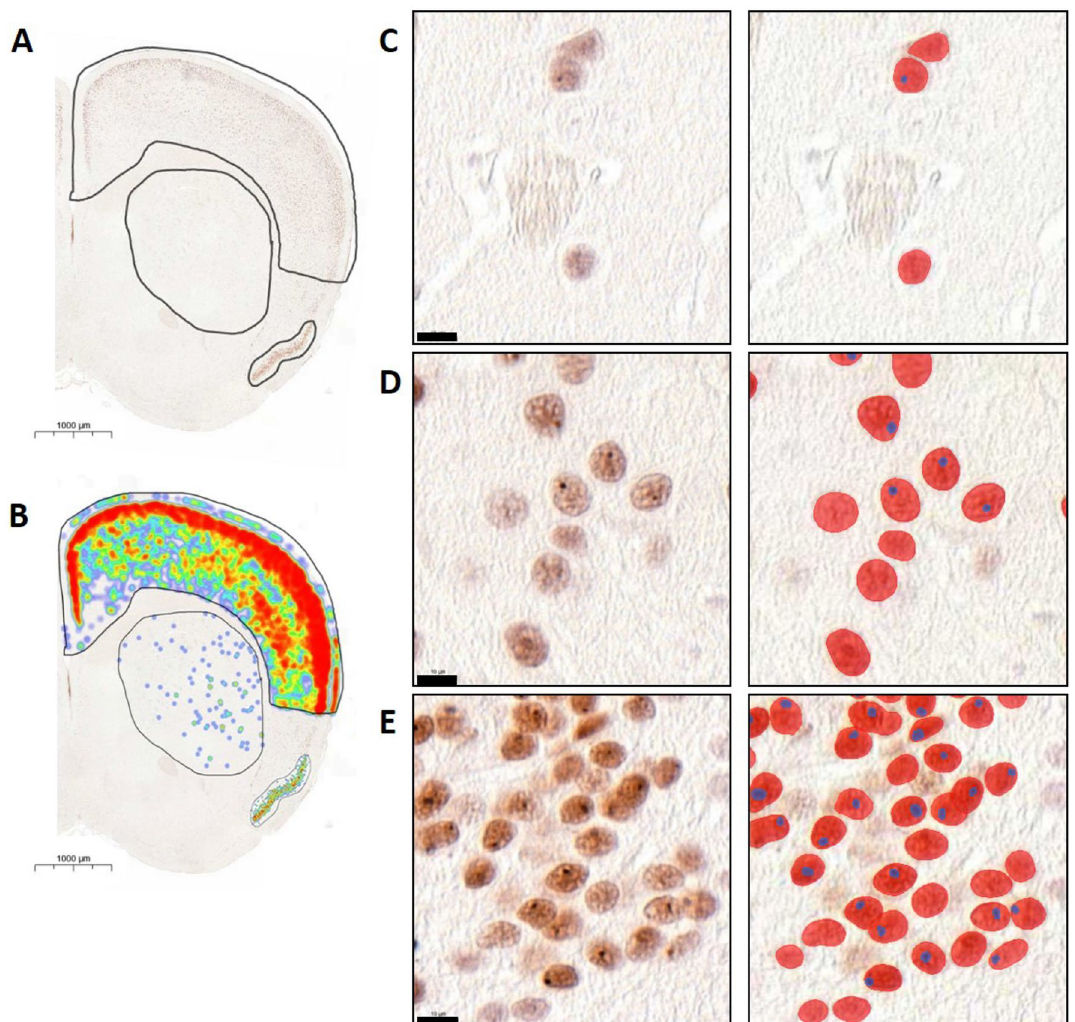
Figure 6. Analysis for EM48-immunopositive mutant huntingtin aggregates using Deep neural network based Aiforia platform. Representative image of a single N171-82Q animal (male, 23 weeks age old). ( A ) Areas (neocortex, striatum and piriform cortex) of the N171-82Q mouse brain, which were analyzed using Aiforia. ( B ) Heatmap of analysis outputs, showing the expression profile distribution of EM48-immunopositive mutant huntingtin aggregates in the respective analysis regions ( A–B ) Magnification: 1.0×. Scale bar = 1000 μm. ( C–E ) High power zoom of the mHtt aggregates. Red-colored is the area of EM48 positive mHtt aggregates, blue- colored is the area of EM48-labeled intranuclear inclusions. ( C ) striatal area, ( D ) neocortex area, ( E ) piriform cortex area. ( C–E ) Magnification 100.0×. Scale bar = 10